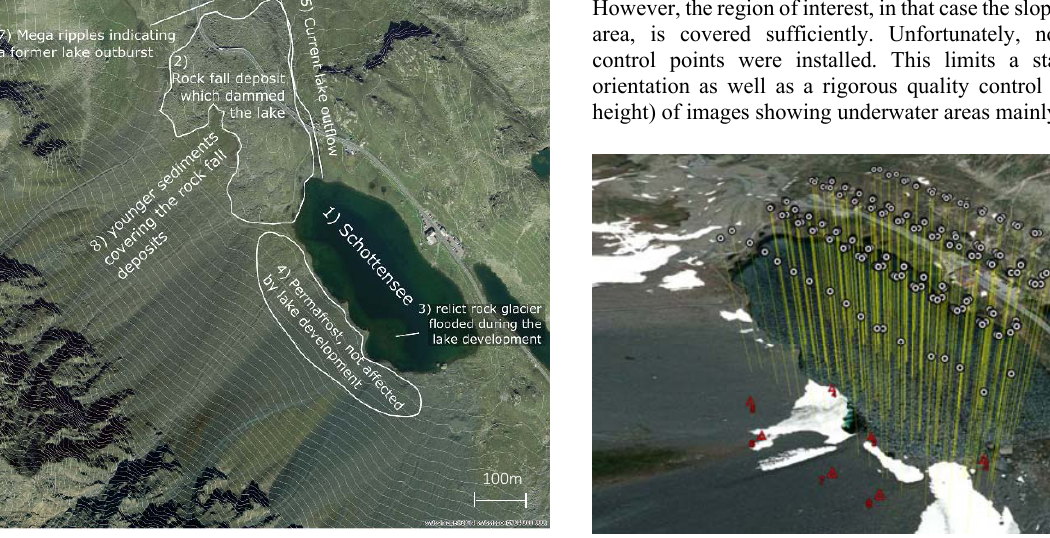
Figure 2. Lake Schottensee with image-positions and